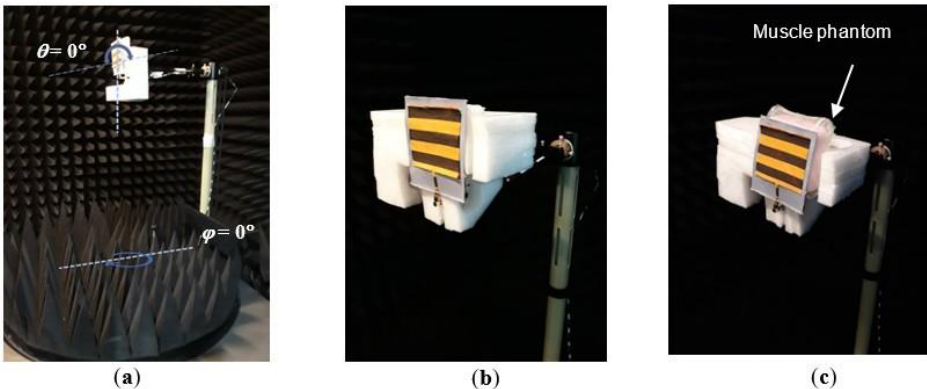
Figure 10. ( a ) Measurement configuration for the radiation pattern, showing the starting point of θ and ϕ ; ( b ) Antenna configuration in free space (Case A); ( c ) Antenna configuration in the presence of the muscle phantom (Case B). Readings were recorded at every 2 ◦ for both θ and ϕ